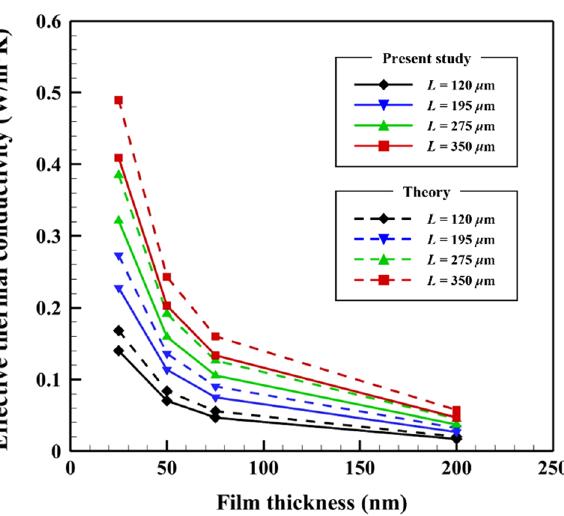
Figure 6. Effective in-plane thermal conductivity due to the SPhPs on the SiO 2 film. Solid and dashed lines represent the values obtained from the BTE and theory 9 ,